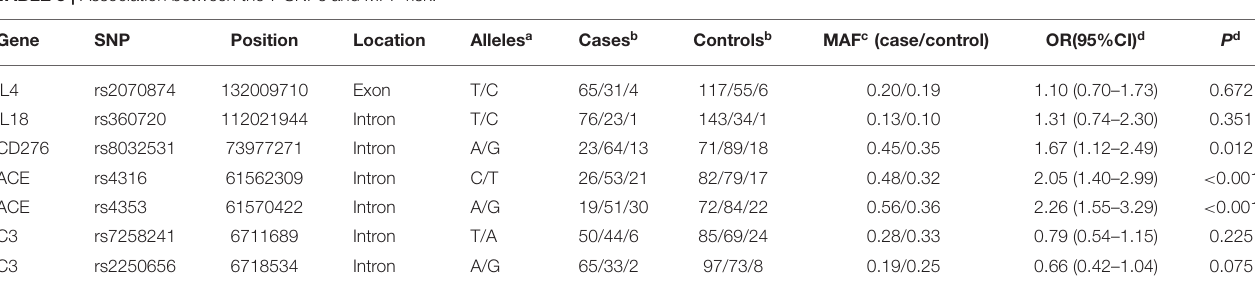
TABLE 3 | Association between the 7 SNPs and MPP